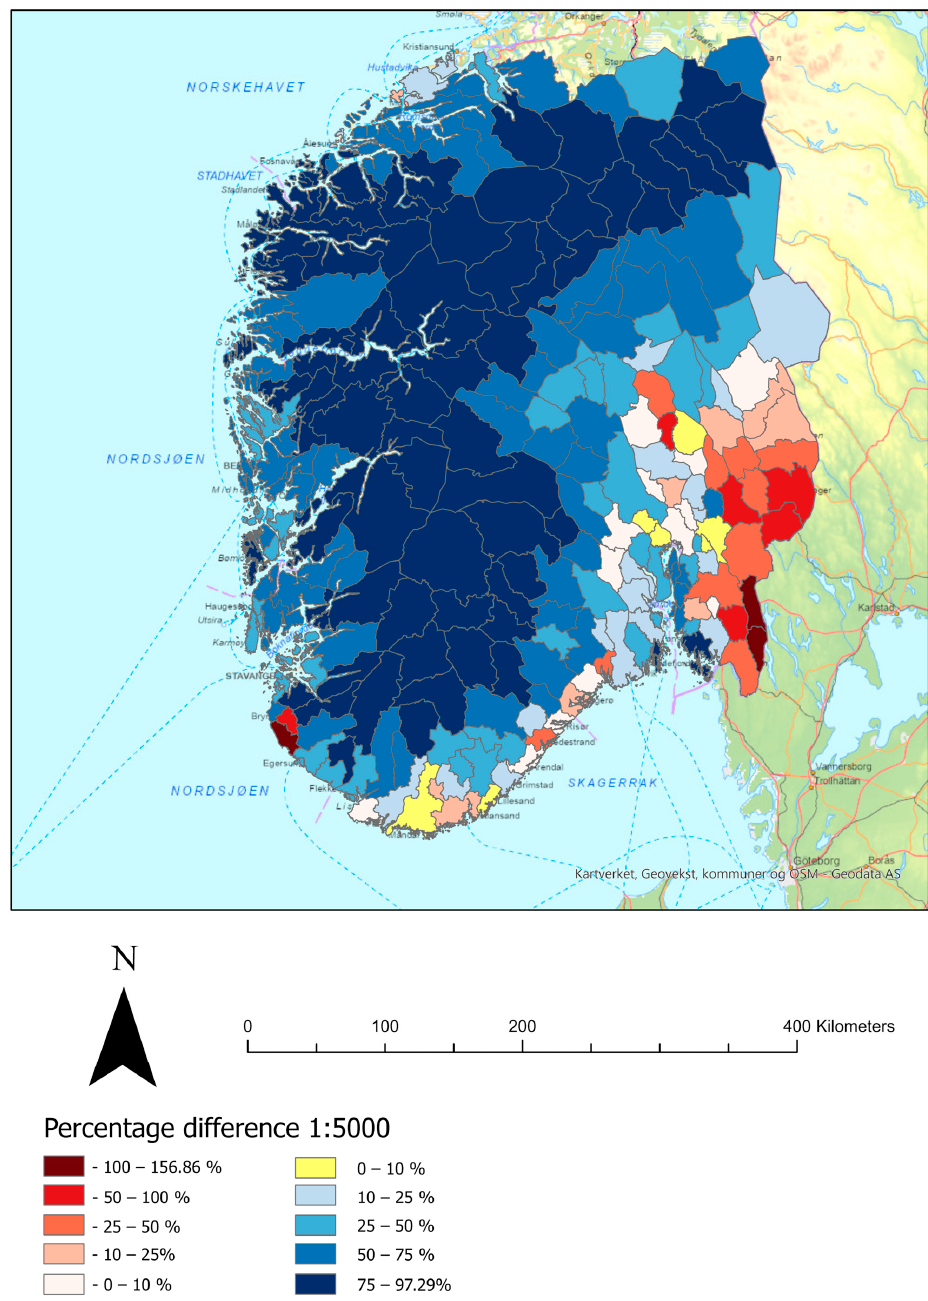
Figure 4. Visualization of the differences in predicted wetland coverage and existing reference data at the scale of 1:5000. Note that the 1:5000 maps do not cover mountain areas, and the large